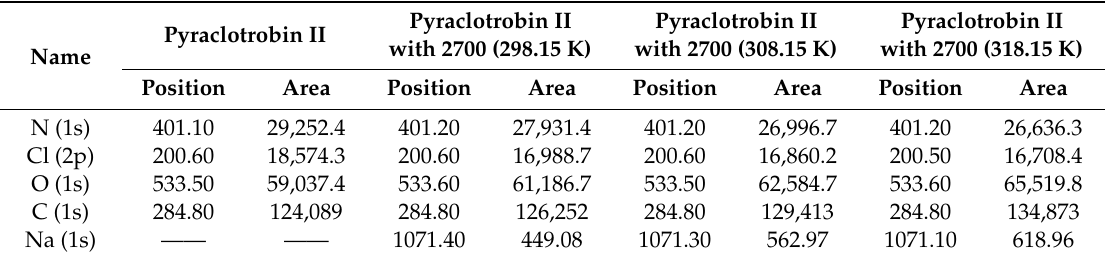
Table 4. Electron bonding energy and concentration of each element in pyraclostrobin crystal II with adsorbed 2700.